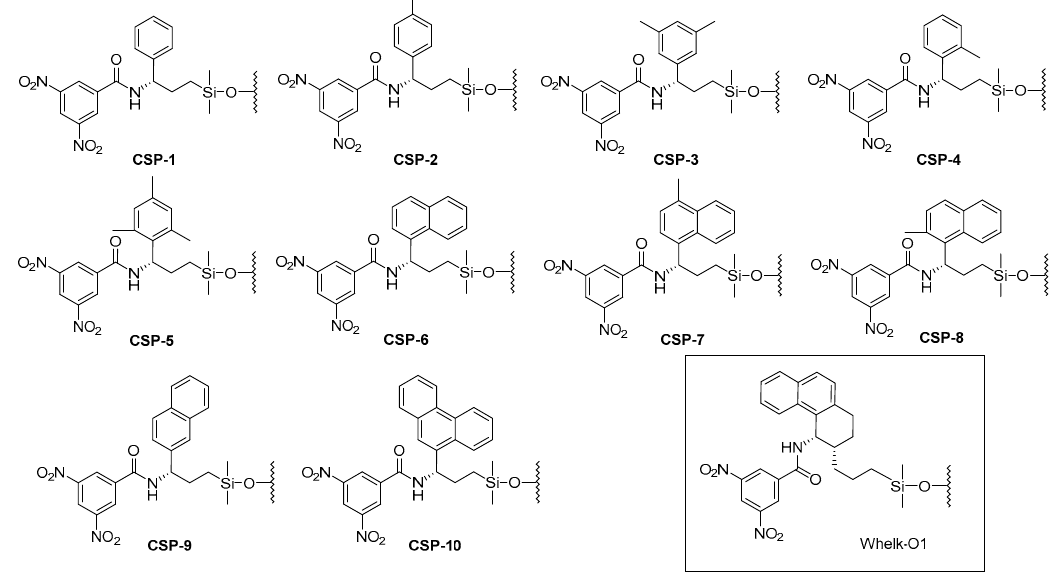
Figure 1. Structures of new brush-type CSPs and Whelk-O1.